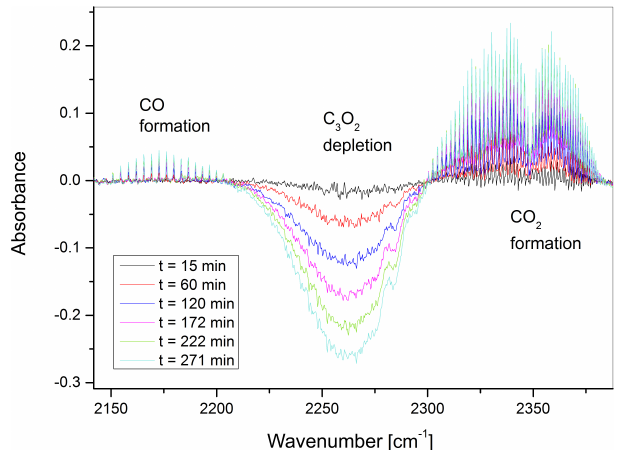
Figure 9. Relative concentration change of C 3 O 2 at various reac- tion times in the presence of nine different O 3 concentrations. All experiments were performed at room temperature ( ∼ 295K) and at a pressure close to 1bar.